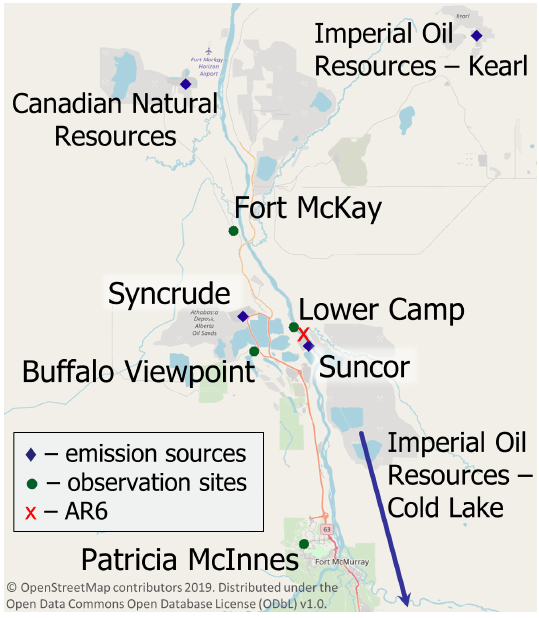
Figure 2. Map of the AOSR with the main point sources for Hg emissions from oil sands developments and air observation sites. “AR6” marks the approximate midpoint of operations as defined by Kelly et al.